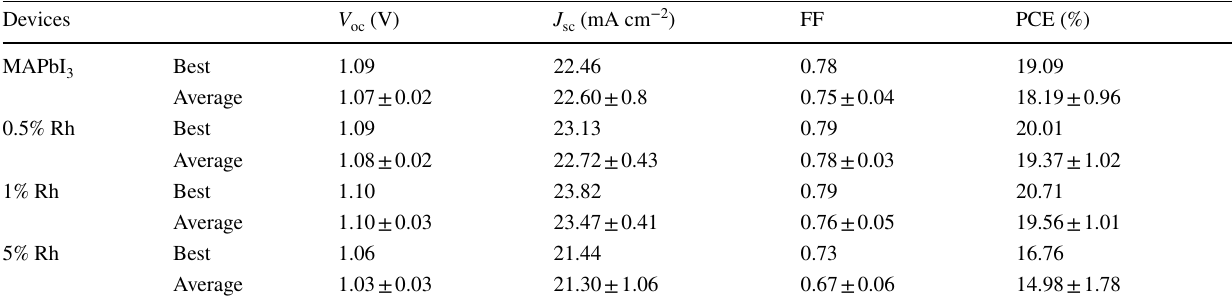
Table 1 Device photovoltaic parameters of devices based on MAPbI 3 : x Rh (where x = 0, 0.5%, 1% and 5%) Devices MAPbI